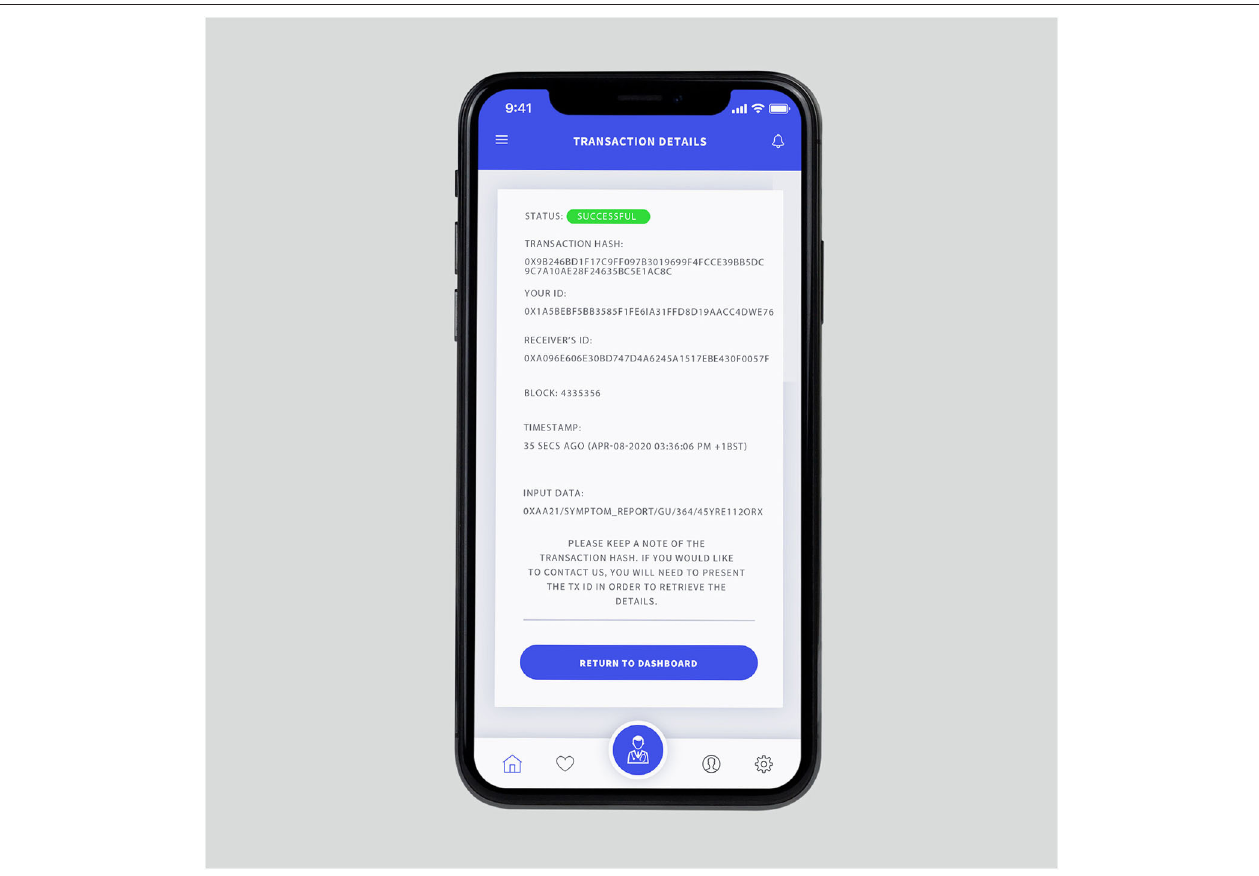
FIGURE 4 | Transaction page showing a successful deployment. It contains the transaction hash, sender’s and receiver’s public keys, block number, timestamp for the block and the input data. The users can keep a copy of the transaction hash, which is an alternative to an “order